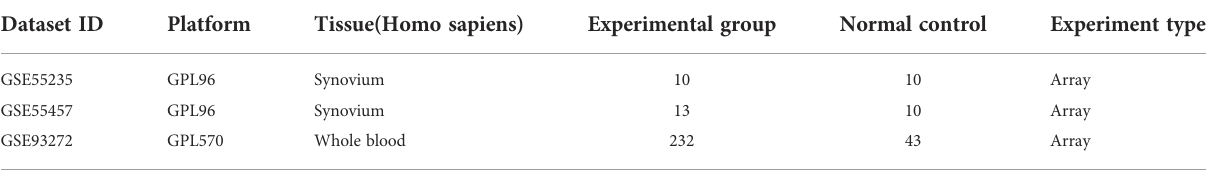
TABLE 1 Basic information of selected